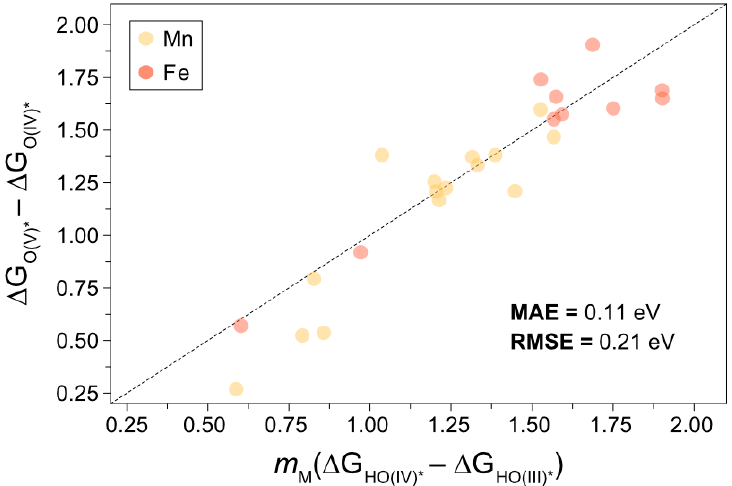
Figure 3. Parity plot showing that Equation (9) holds for Fe and Mn catalysts considered in this work using the scaling relations presented in Figure S7 with m M values of 1.18 and 1.36 for Fe and Mn, respectively. The dashed line denotes the equation y = x